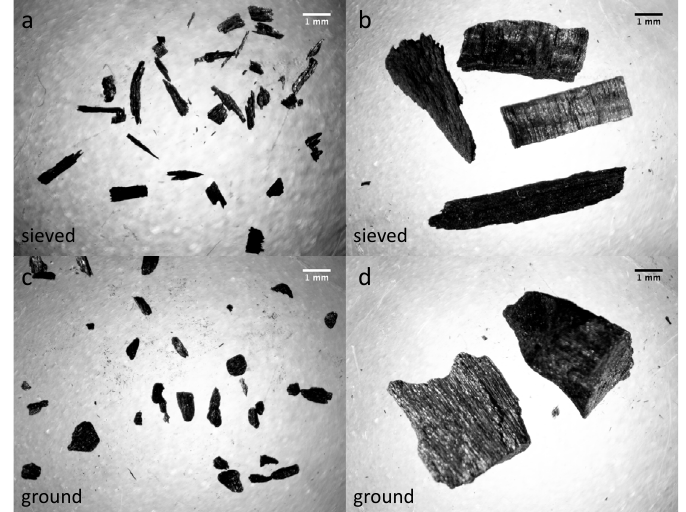
Figure 1. Biochar particles of varying size and shape generated by sieving and grinding “raw” biochars. ( a ) and ( c ) are biochar particles between 0.0635 mm and 0.5 mm; ( b ) and ( d ) are biochar particles between 2 mm and 4 mm. ( a ) and ( b ) (elongated) are biochars obtained by direct sieving from biochars pyrolyzed from sawdust; ( c ) and ( d ) (round) are biochars obtained by grinding and sieving from biochars pyrolyzed from woodchips.